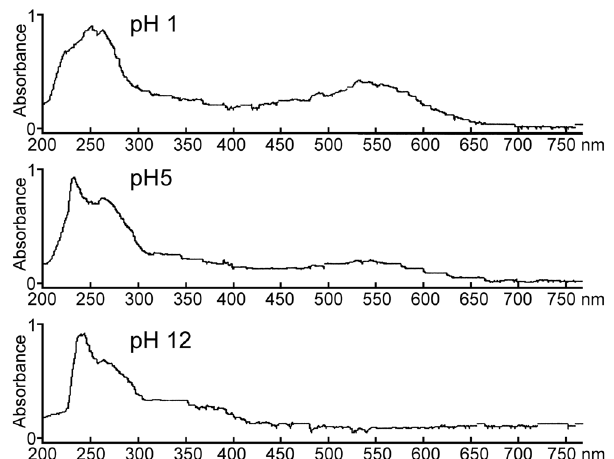
Figure 2. Pink pigment spectra from 200 to 760 nm. The scan at pH 5 of the purified pink pigment revealed two peaks in the UV range (231 and 265 nm). A single peak was seen in the visible range (538 nm). The scan at pH 1 shows a shift in the UV peaks to (250 and possible 260 nm) and a single enhanced peak (at 538 nm). The scan at pH 12 reveals a UV peak at 243 nm which had a large shoulder and the peak at 538 nm has disappeared. The disappearance of the peak at 538 nm corresponded to the pink pigment becoming colorless above the pH of 6.0.